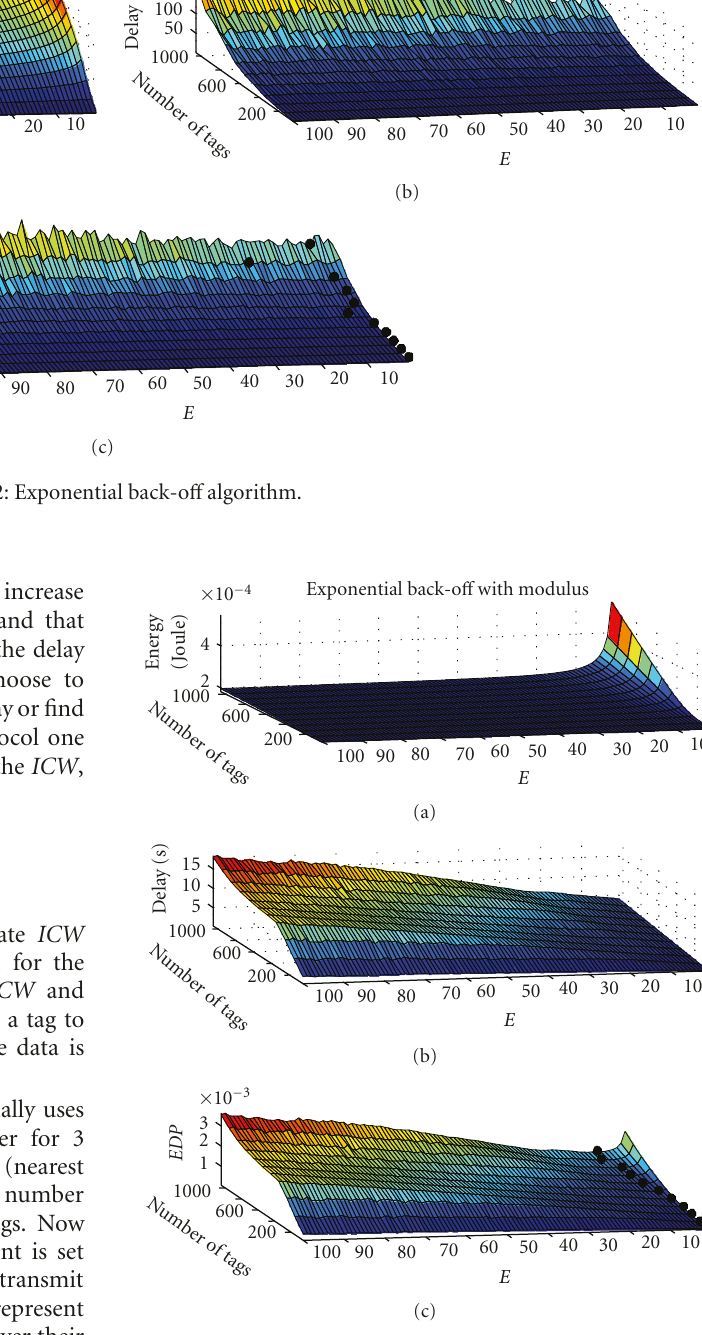
the simulated algorithms but with the number of tags fixed to 50 and 1050, respectively. In the case of 50 tags and long delay (over 450 ms), Table 4 shows that any of the algorithms can be chosen and that the energy consumption is the same for all. For short delays, less than 250 ms, only the constant and the linear modulus can be